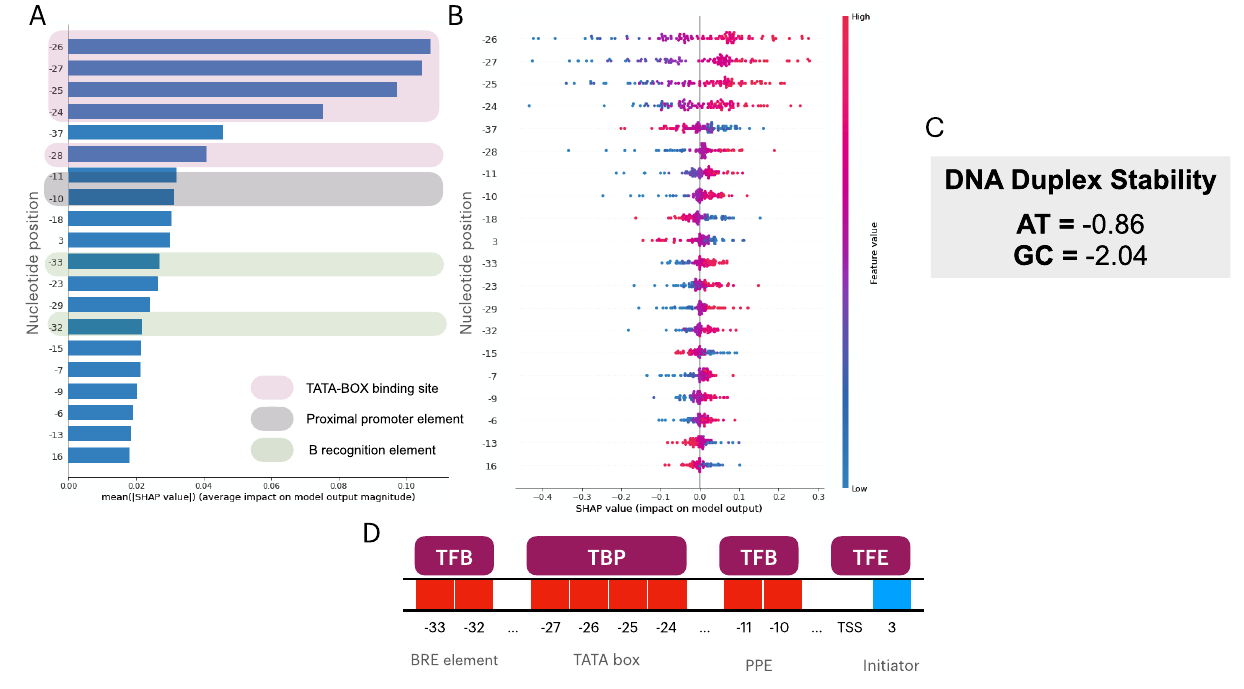
Figure 3. Interpreted SVM model in predicting archaeal promoter sequences. In ( A ), we show the variable importance of the main 20 input features considered by the SVM model in order to classify promoter sequences from archaea. Next, in ( B ), we measured the SHAP impact of each variable in classifying 100 random promoter sequences from the train/test data. The average impact on SHAP (x axis) might be either positive or negative for a specific observation. The fine balance of reds and blues in our model indicated the success of the SVM in labelling these promoters correctly. Therefore, the decision pattern of the model considered a positive SHAP average (i.e., more chances of it being classified as a promoter) for sequences whose input features were either negative or positive, according to the y axis. Next, in ( C ), we averaged the impact on stability of GC (GG, GC, CG, or CC) and AT-composed dinucleotides (AA, AT, TA, AA). Finally, in ( D ), we mapped some of the input features from Fig. 2A,B to match the binding site of TBP, TFB, and TFE proteins. Both panels A and B were outcomes of the SHAP package in Python (version